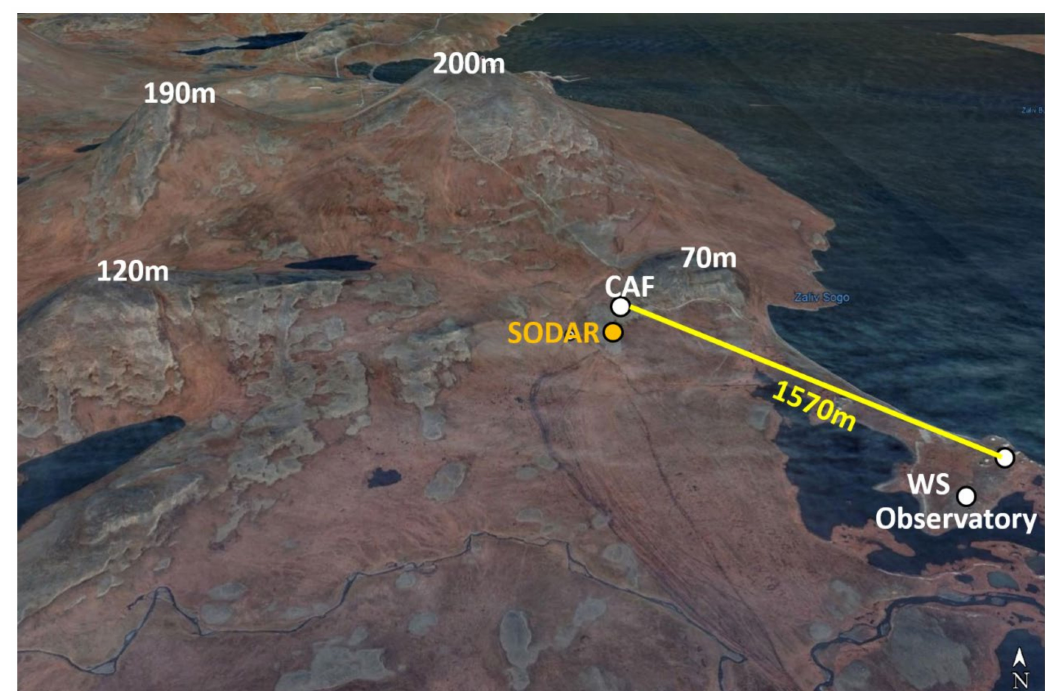
Figure 4. 3D view from the south of the investigation area (Google Earth 2021). The SODAR and Radio Acoustic Sounding System (RASS) was installed south of the clean air facility (CAF). The Tiksi micro-meteorological tower (20 m height) is located approximately 315 m south-west of the CAF (see maps in Figures S1 and S2 in the supplement). The scintillometer measured between the observatory and CAF. Standard meteorological observations are taken at the weather station (WS). The elevations of some hill tops are indicated.